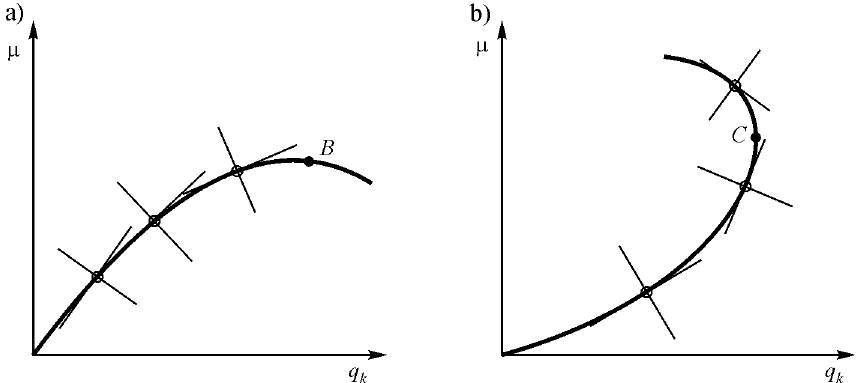
Figure 3. Tracing an equilibrium path with ( a )limit point, ( b ) turning point.